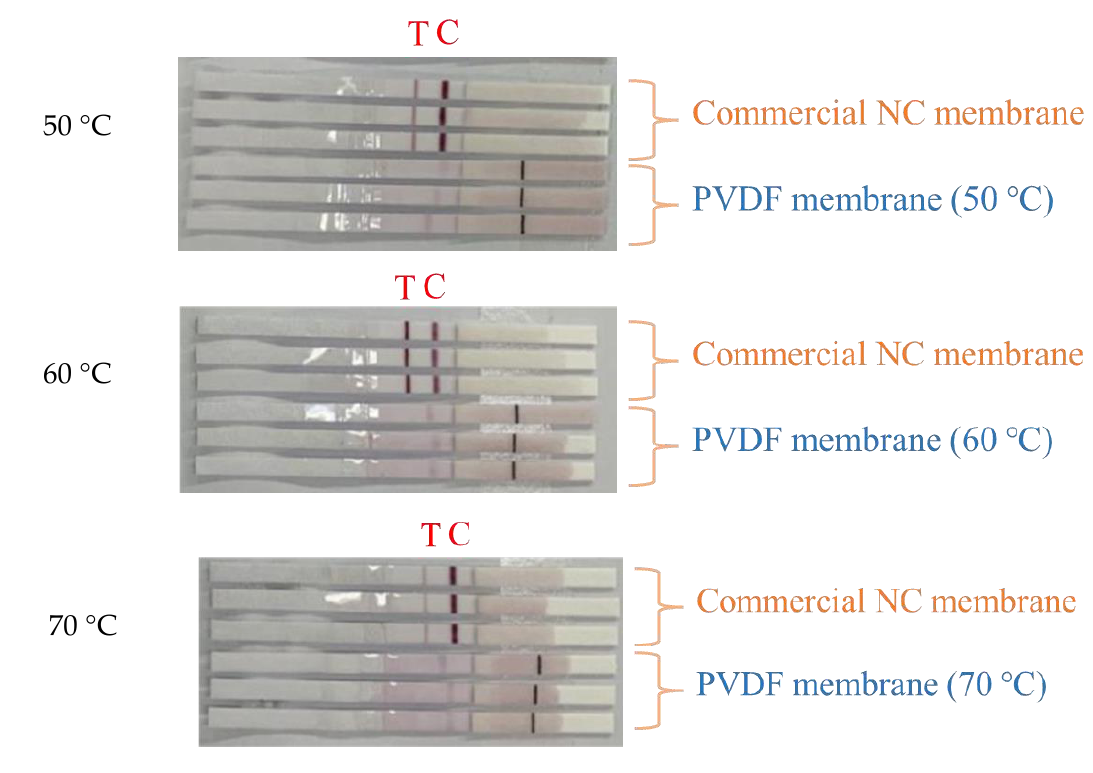
Figure 8. Application of colloidal gold test strips of PVDF membrane prepared at different vapor temperatures.